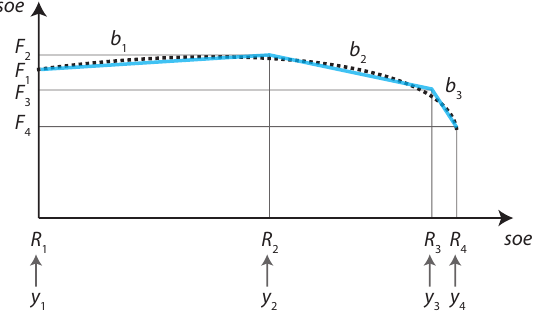
Figure 1. Piecewise linear approximation of an soe – ∆ soe